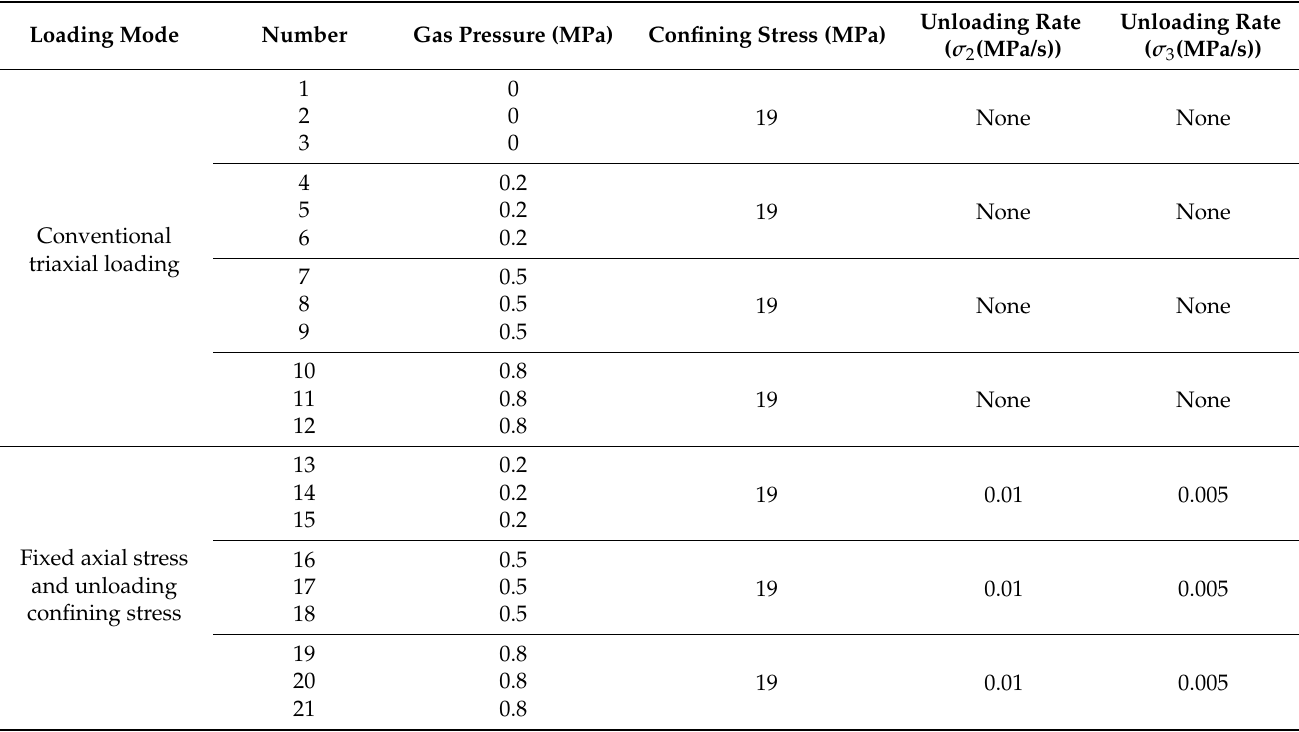
Table 1. Experimental conditions of coal